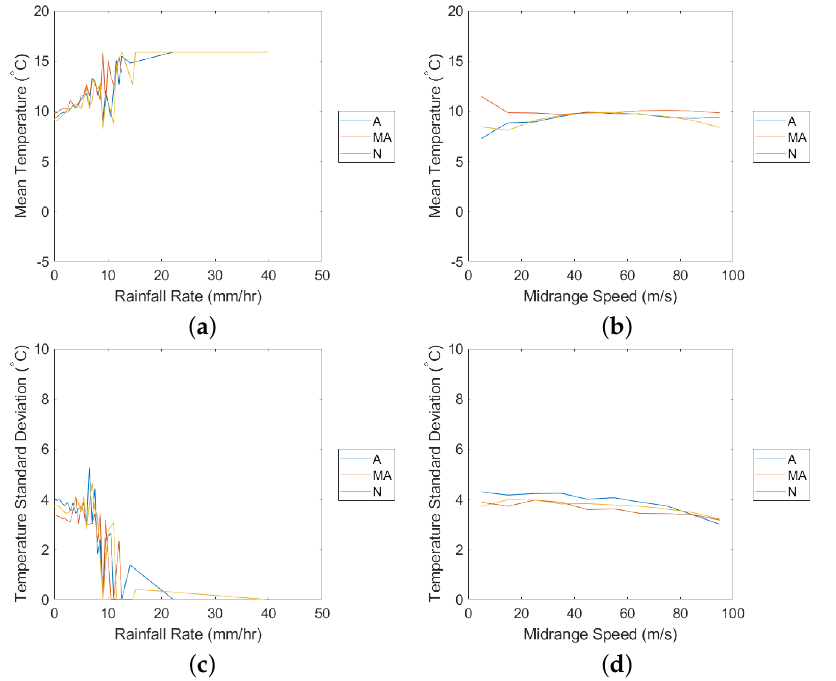
Figure 17. Mean ( a , b ) and standard deviations ( c , d ) of data presented in Figure 16 against the midrange tip speed of each bin, for the respective stations. Table 2. Distributions of mean and median temperatures for rainfall hours and n A across all stations. Temperature